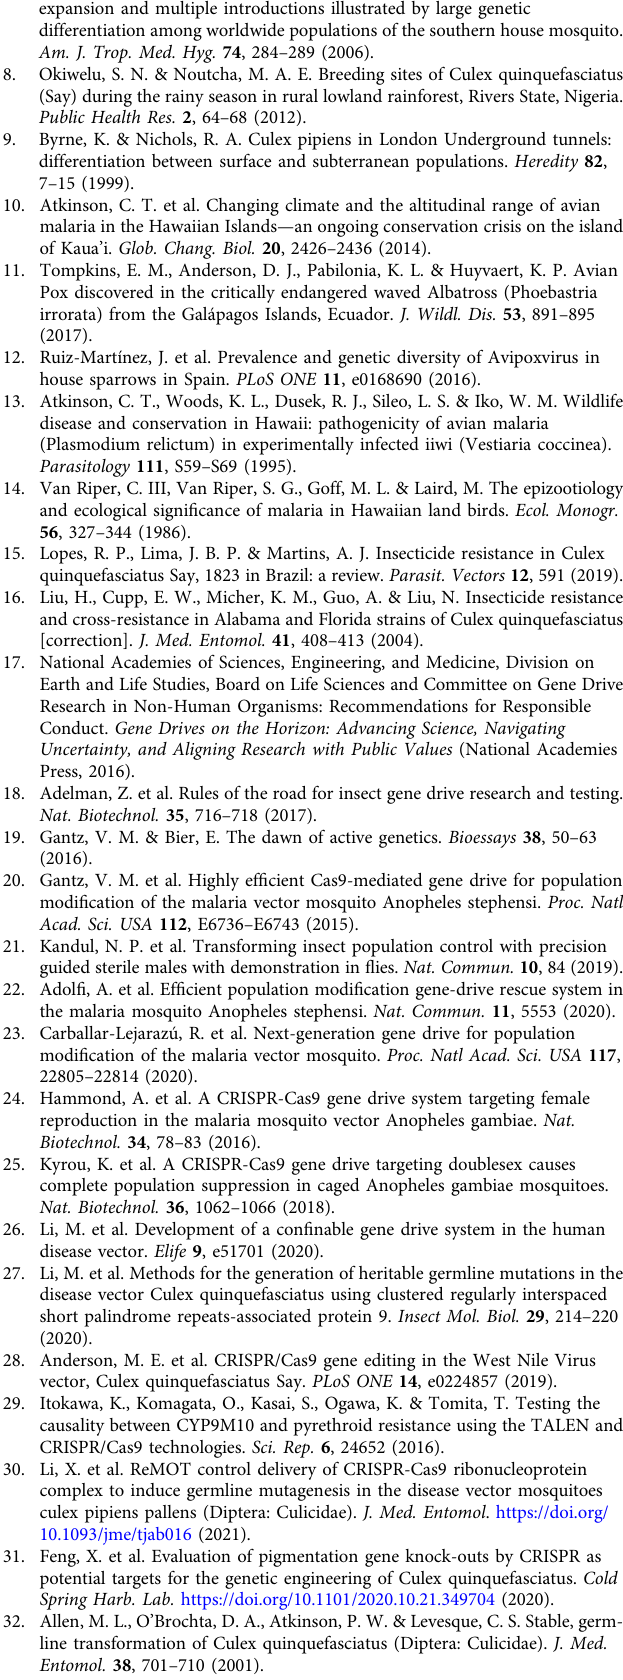
rates separately (Supplementary Data